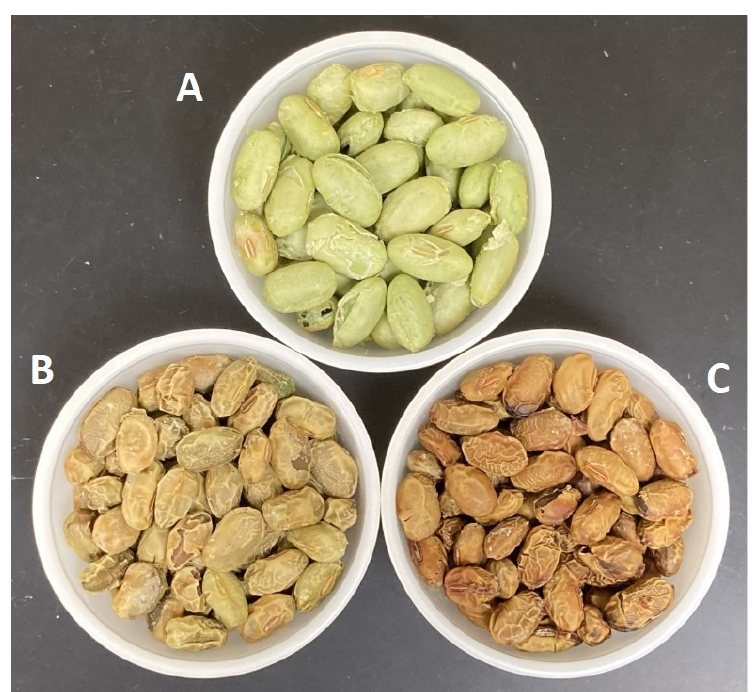
Figure 1. Dried edamame seeds of line VS15-6021. ( A ) fresh seed dried by freeze drying, ( B ) fresh seed dried by low-heat drying, and ( C ) fresh seed dried by high-heat drying.